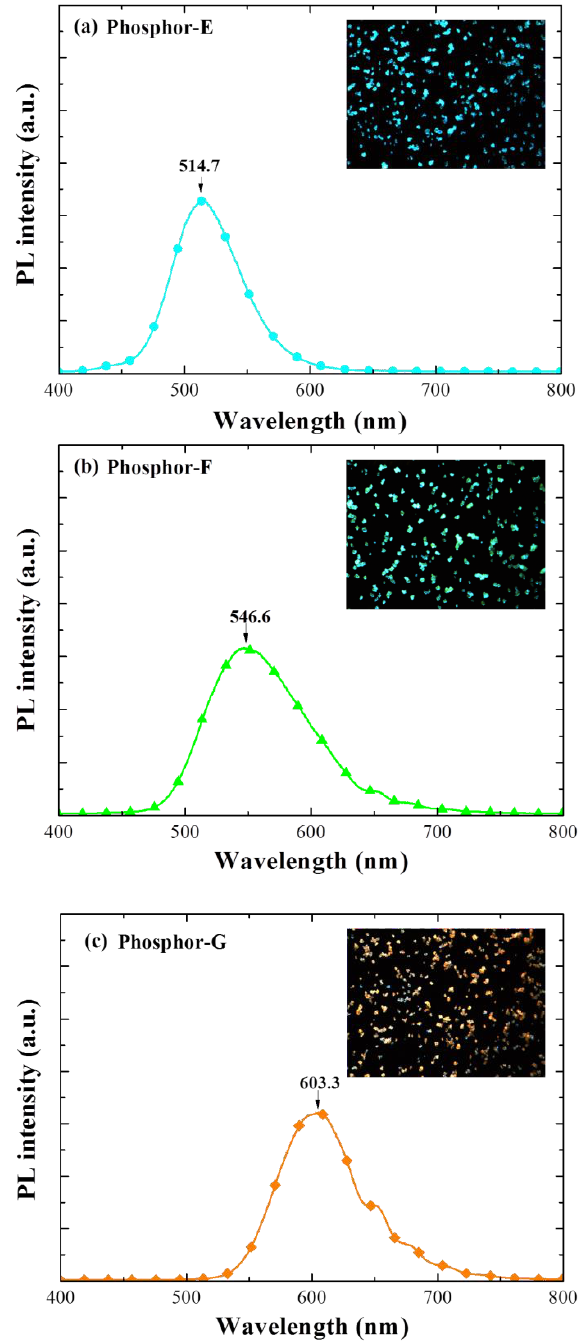
Figure 5. PL spectra and color optical emission images, for the samples with a SiO 2 layer containing single phosphors: ( a ) Phosphor-E, ( b ) Phosphor-F, and ( c ) Phosphor-G.